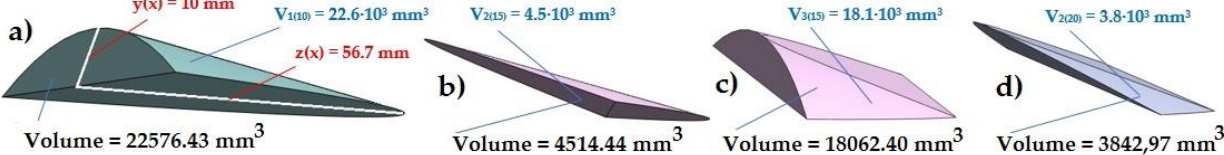
Figure 6. Batch volume of the transported material (see Table 2) ( a ) V 1(10)*1 (cm 3 ), ( b ) V 2(15)*1 (cm 3 ), ( c ) V 3(15)*1 (cm 3 ), ( d ) V 2(20)*1 (cm 3 ).